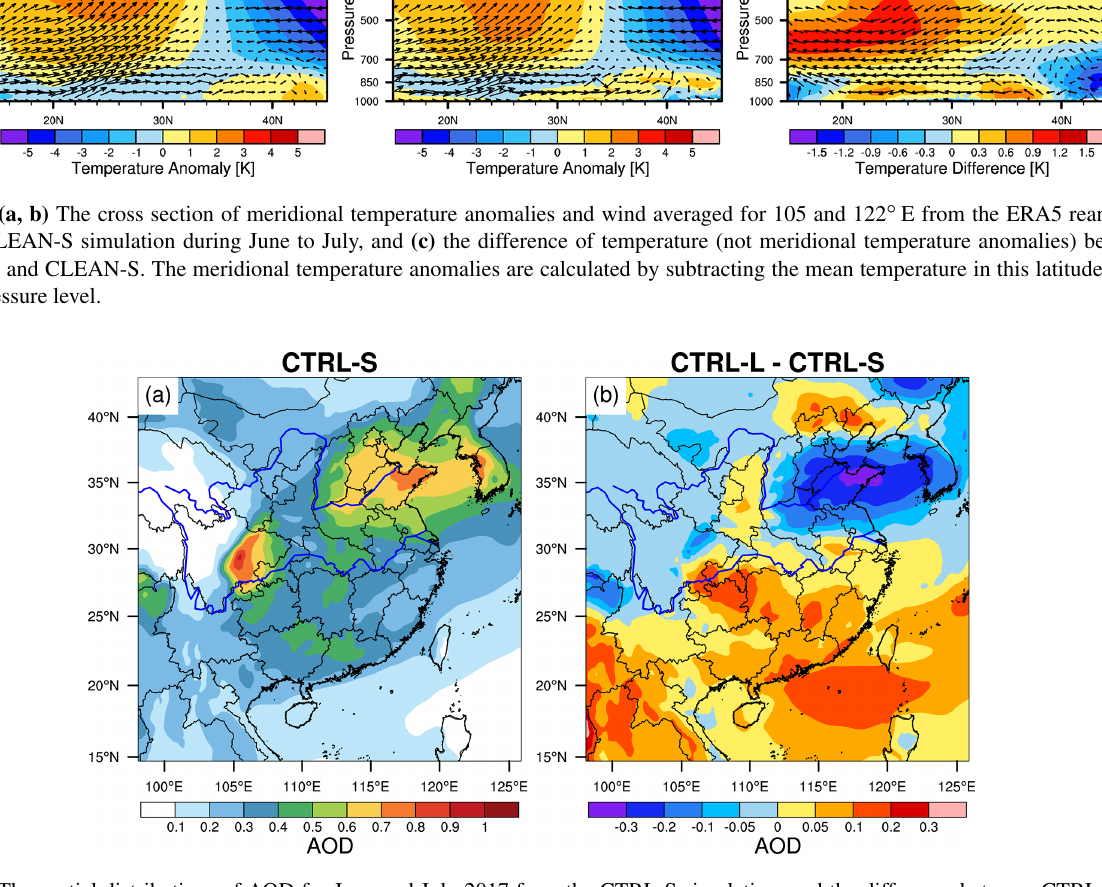
Figure 5. The spatial distributions of AOD for June and July 2017 from the CTRL-S simulation, and the difference between CTRL-L and